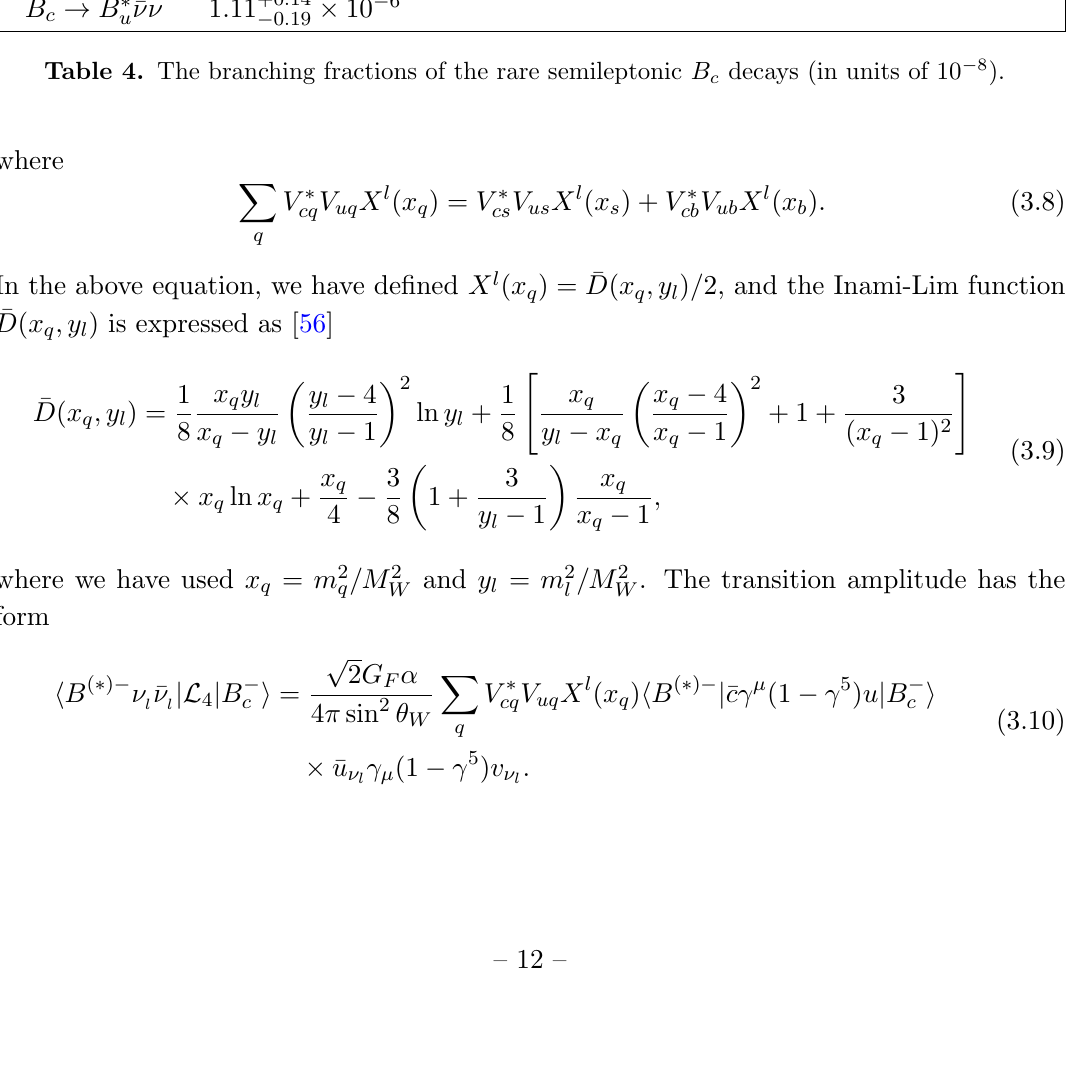
Table 4. The branching fractions of the rare semileptonic B